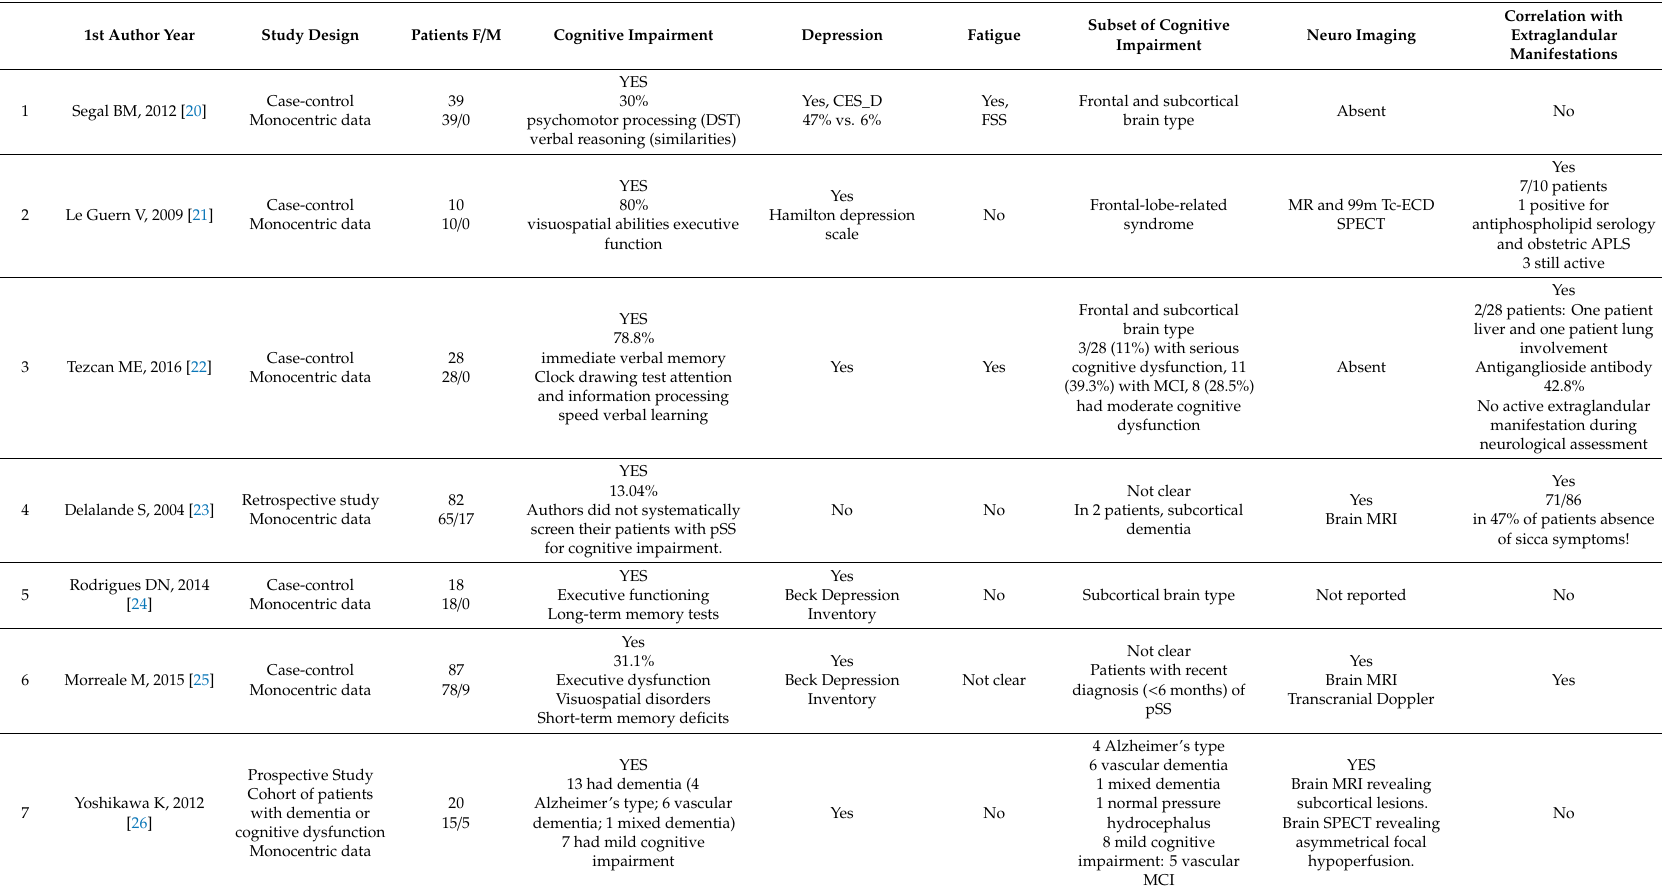
Table 1. Characteristics and main data of the studies included in this